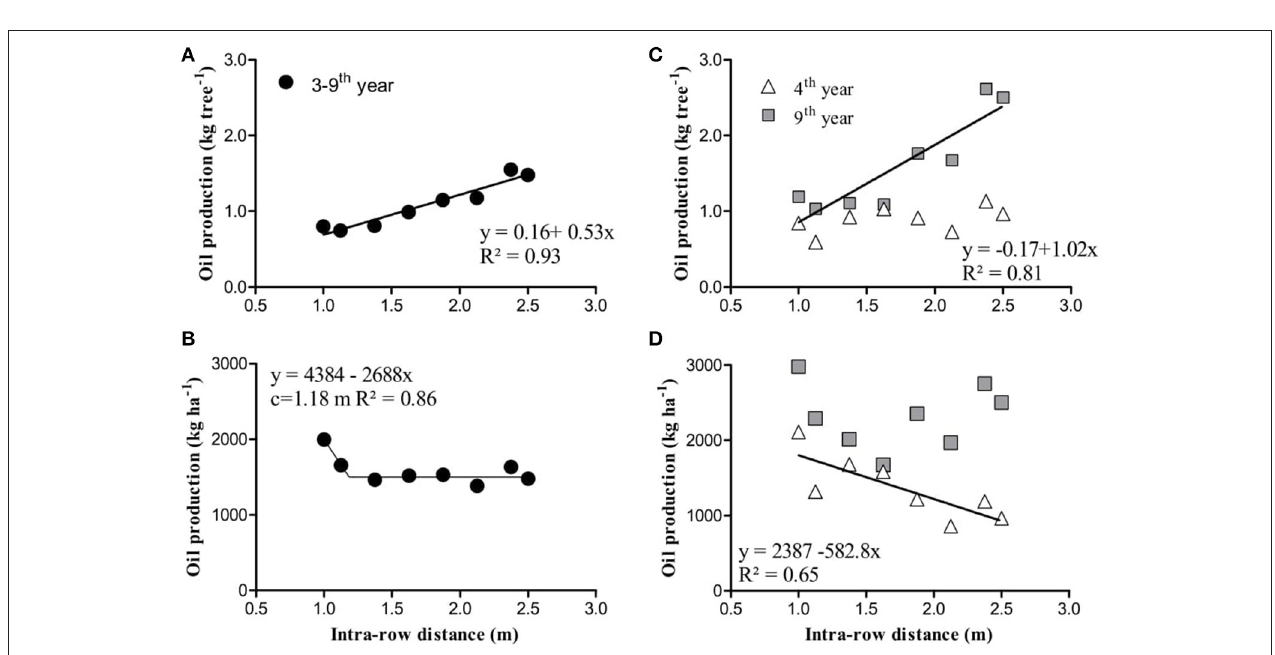
FIGURE 6 | Mean oil production of olive hedgerows established with trees at various intra-row distances; per tree (A) and per ha (B) for the first seven harvested years, and in the fourth and ninth year after planting per tree (C) and per ha (D) . Each point is a mean of 3 replicates.